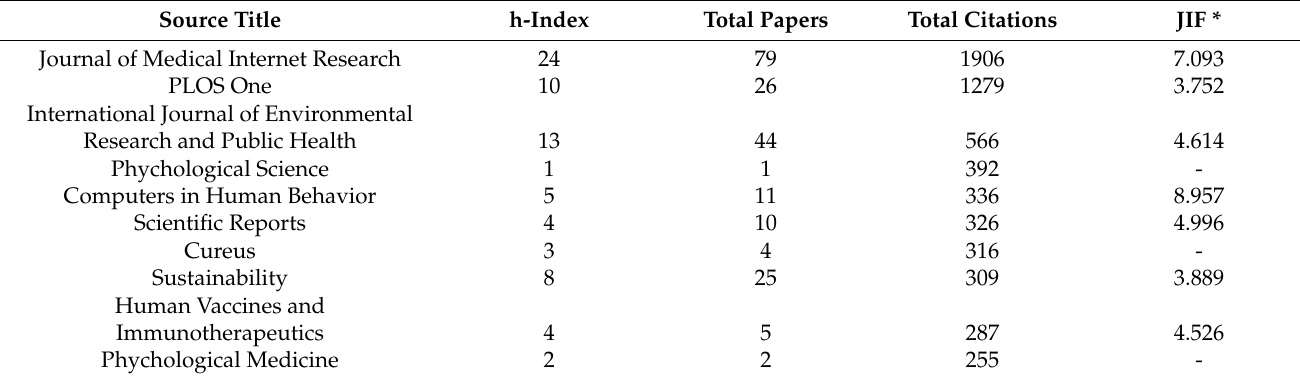
Table 5. Top 10 most influential sources based on total